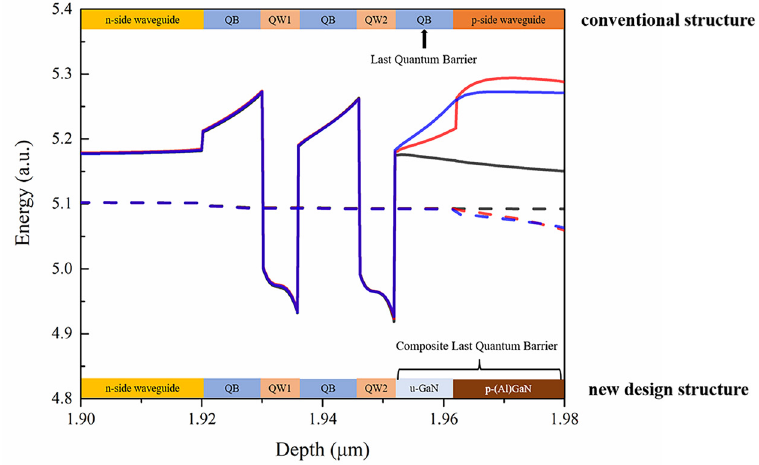
Figure 1. The conduction band diagram of some layers around the MQW region of InGaN-based violet LDs. The conventional structure with u-GaN LQB (black) and the new design structure with p-AlGaN/u-GaN CLQB (red) or p-GaN/u-GaN CLQB (blue). The dashed line represents the electron Fermi level. The energy scale has been vertically shifted to keep the Fermi level consistent.